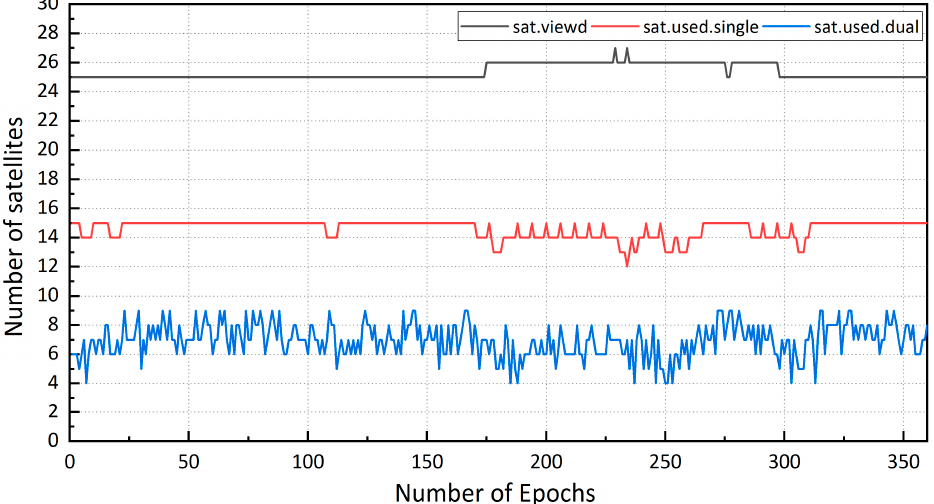
Figure 10. The number of satellites observed by smartphone.